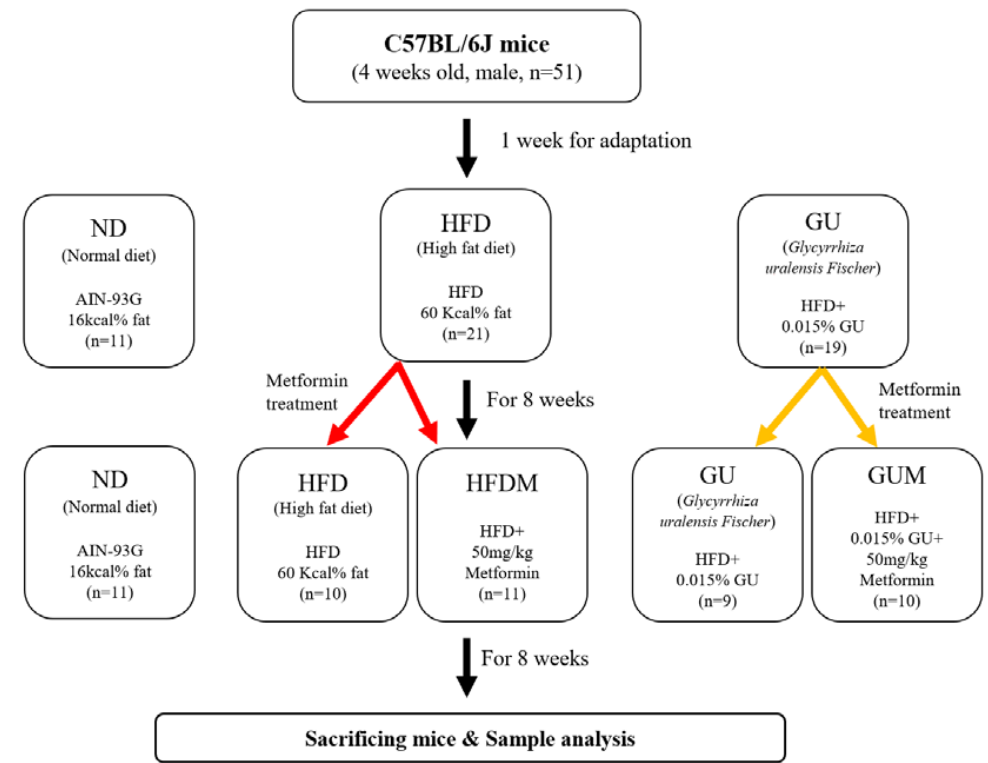
Figure 8. Experimental design.